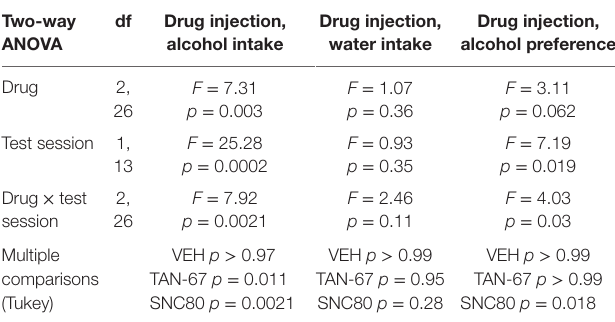
TaBle 3 | Two-way, repeated measures ANOVA of alcohol-related behaviors in β -arrestin-2 knockout mice upon biased delta-opioid receptor agonist infusion in the dorsal striatum.